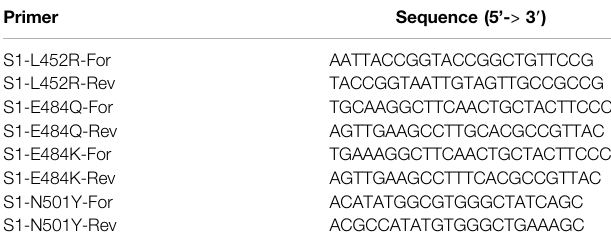
TABLE 1 | List of mutagenesis primers used to generate S1 mutations of